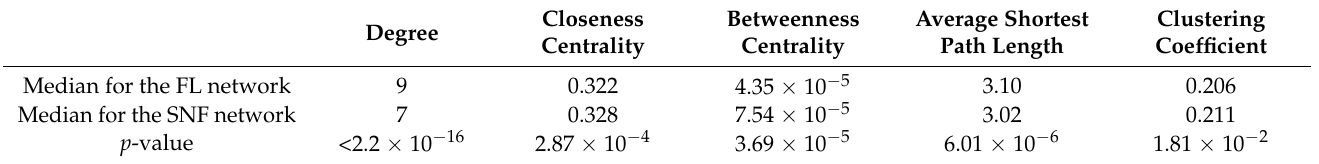
Table 1. Comparison of local topological properties between the PPI networks of the FL and SNF states ( p -values were obtained by two-sided Wilcoxon rank sum